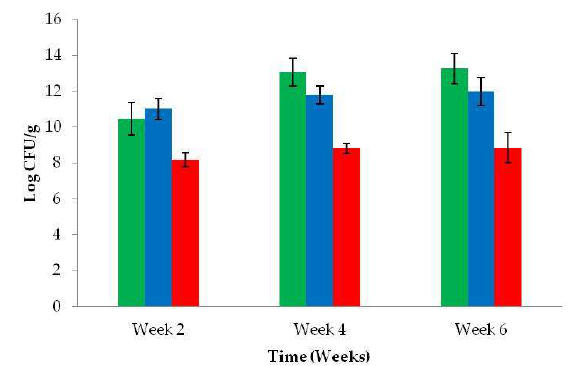
Figure 4. Evolution of microbial count during 6 weeks (45 days) of treatment. Treatment with carrot peel waste ( ■ ); Treatment with carob ( ■ ); and Control without treatment ( ■ ). Error bars represent the standard error of replicates. CFU: Colony Forming Unit.